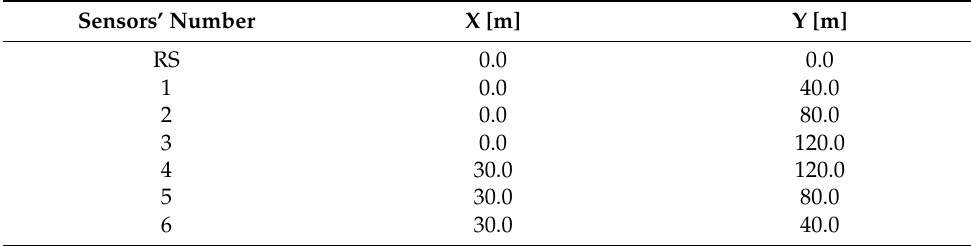
Table 4. The rectangular values of sensors X, Y [m]. Sensors’ Number